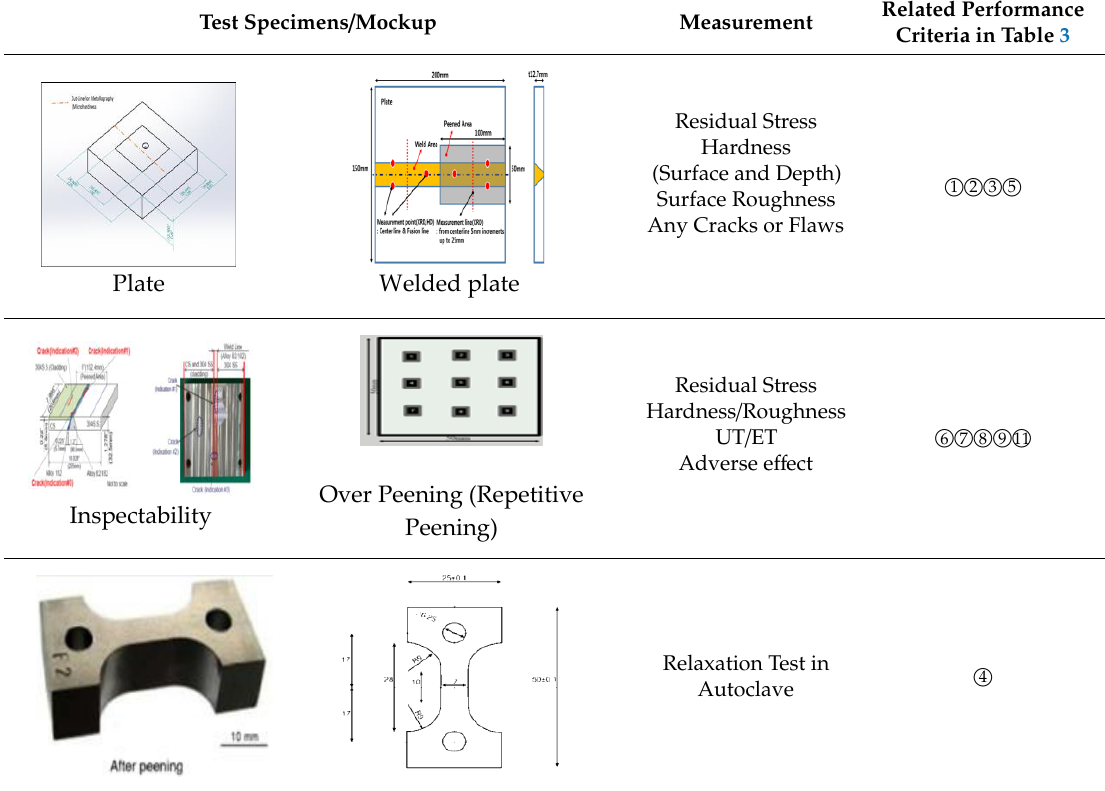
Table 4. Test and demonstration for technical basis: UNSM/ALP. Test Specimens/Mockup